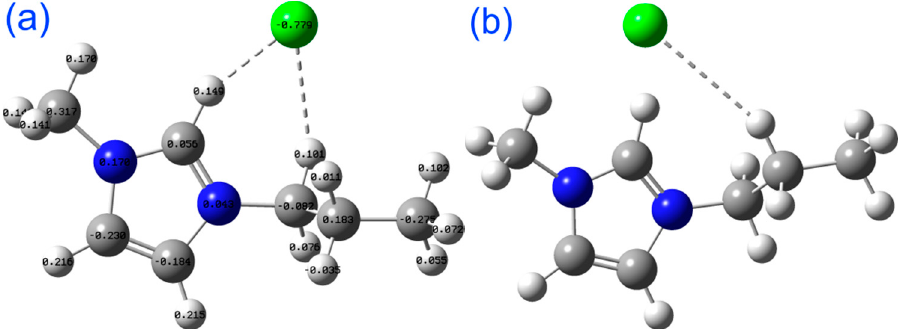
Figure 9. Possible structural relationship between the anion and the cation of the IL [PrMIm]Cl. ( a ) A 6-element or ( b ) 7-element ring forms with the Cl − anion, C, N, and H atoms. Also labeled in the left panel is the charge distribution. Here the blue, smallest light grey, dark gray, and green balls represents N, H, C, and Cl atoms, respectively. Unlike the imidazolium ring, the 6- and 7-element rings are not as stable, since the dashed lines here only indicate moderately strong Coulomb attractions.